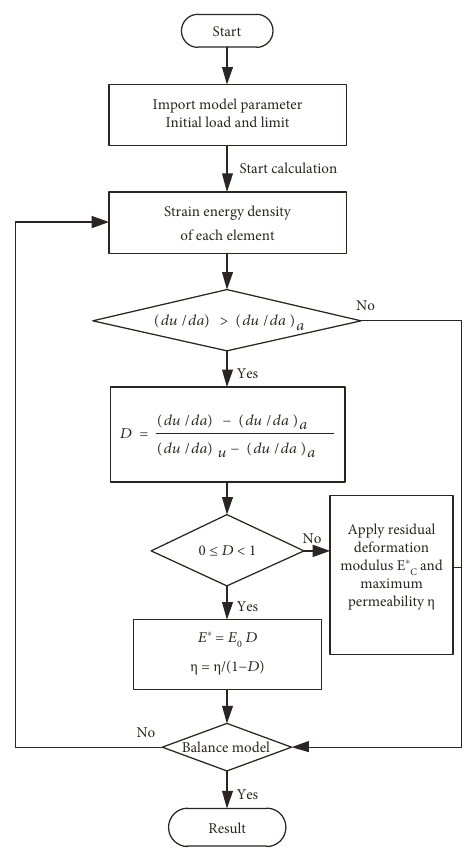
Figure 3: Flow chart of numerical